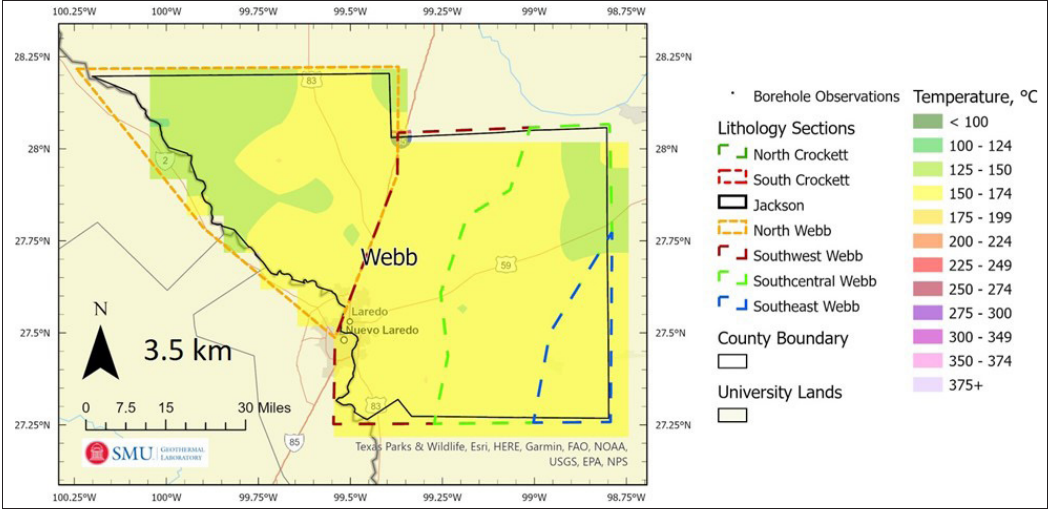
Figure 11. Temperature at 3.5 kilometers (km; 11,500 feet) depth in Webb County. The majority of the county is within the 150–174 °C (300–345 °F) temperature range. The only areas outside this temperature range are the northwestern and eastern corners of the county. Dashed lines represent each area of the four lithology cross-sections (Batir and Richards 2020).